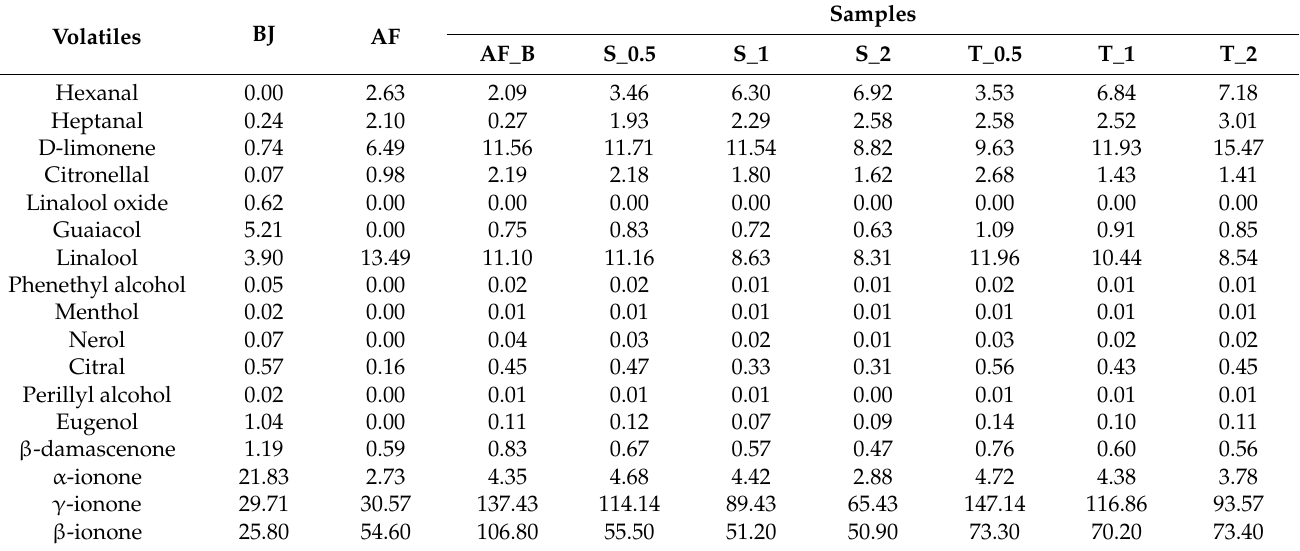
Table 7. Odor activity values (OAVs) of blackberry juice (BJ), apple fiber (AF), and formulated microparticles.